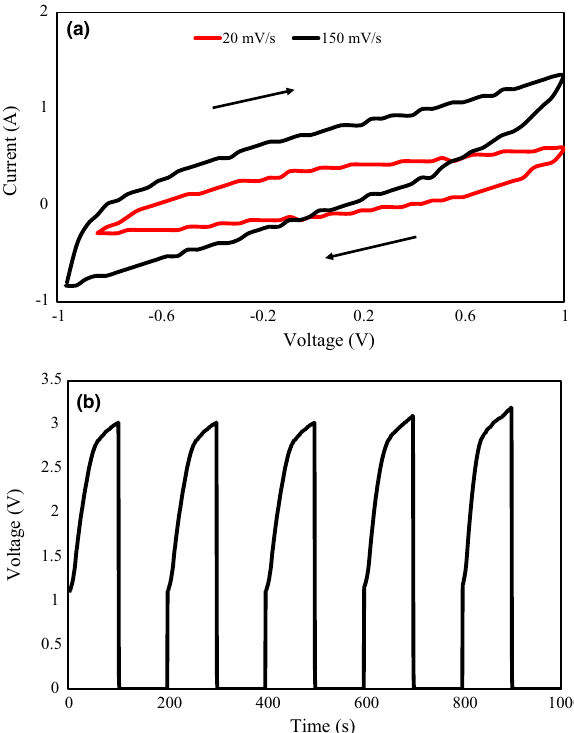
Fig. 5 a Cyclic voltammetry (CV) at 20 mV s −1 and 150 mV s −1 , b